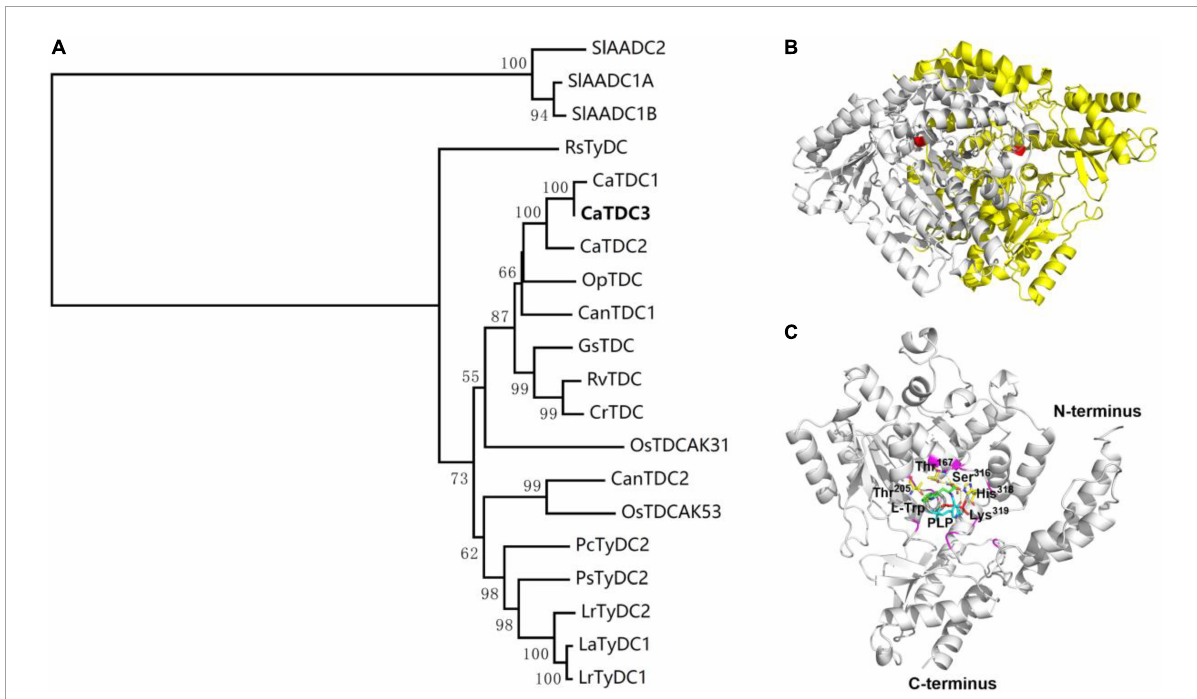
FIGURE4 Phylogenetic relationship of CaTDC3 with plant aromatic amino acid decarboxylases (A) , predicted three-dimension structure of dimeric CaTDC3 (B) , and schematic key active region of CaTDC3 (C) . The amino acid residue sequences of plant aromatic amino acid decarboxylases (AADCs) were obtained by using the NCBI search engine. The phylogenetic tree was constructed by MEGA 7.0 software package and neighbor-joining program with 1,000 boots trapped value support and a Poisson correction. The bootstrap values higher than 50% are given at the nodes. In the homodimer structure of CaTDC3, one was colored in gray and another was in yellow. The key Lys319 was marked in red. The amino acid residues involved in interactions with L-tryptophan are Thr167, Thr205, Ser316, His318, and Lys319. PLP was in